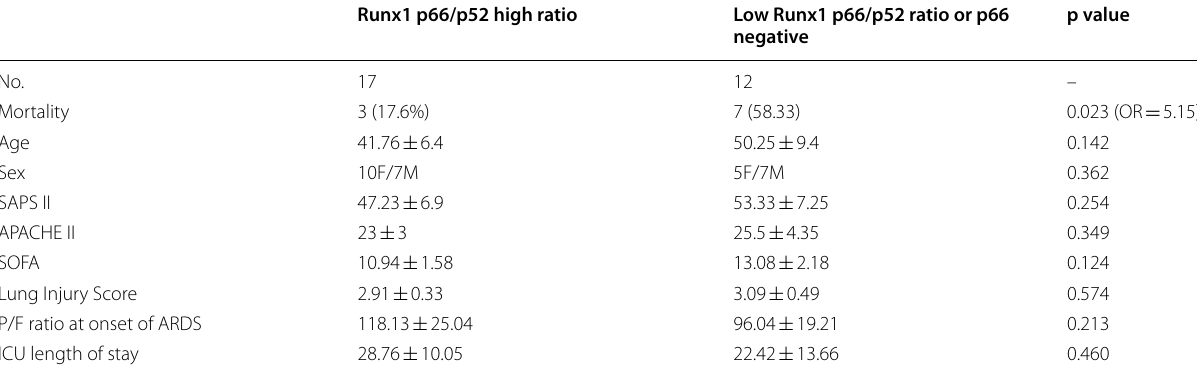
APACHE II Acute Physiology and Chronic Health Evaluation II; SAPS II Simplified Acute Physiology Score II, SOFA Sequential Organ Failure Assessment score, LIS Lung Injury Score, P/F PaO 2 /FiO 2 ratio on the day of diagnosis of ARDS; Values are mean ±